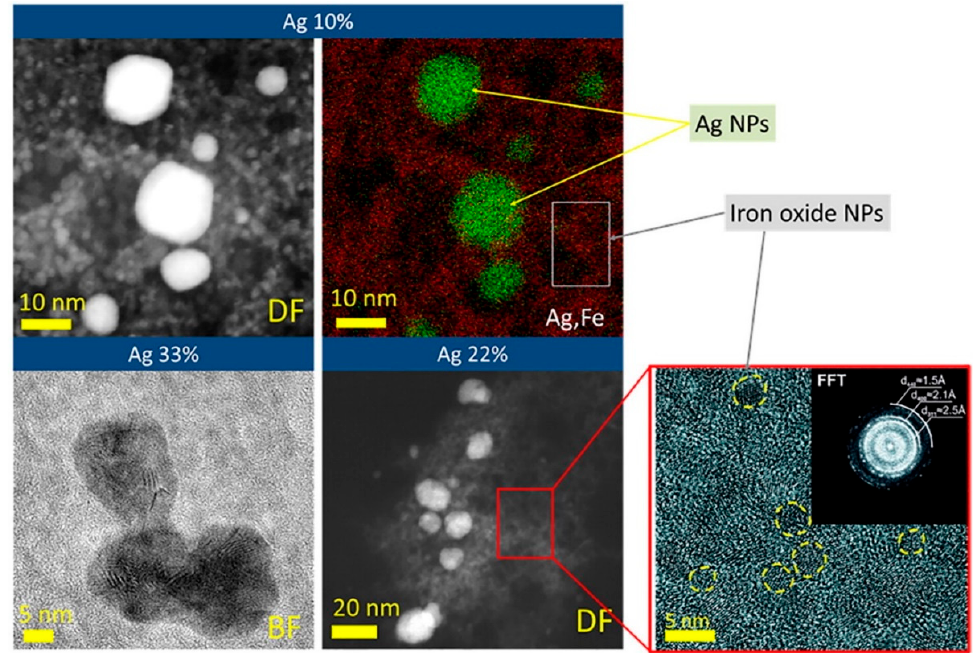
Figure 3. High resolution TEM images showing the Ag-Fe 3 O 4 nanocomposites, and elemental mapping illustrating the location of the silver and iron oxide. Reprinted with permission from [29]. Copyright Elsevier, 2017.